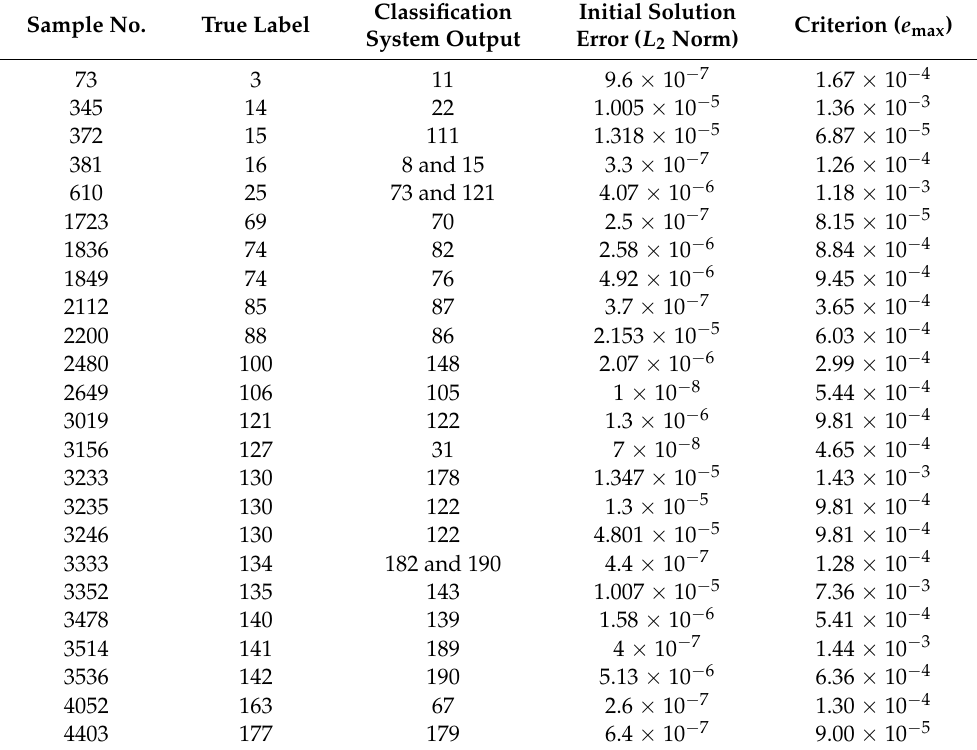
Table 9. Mislabeled cases of the prediction system. Sample